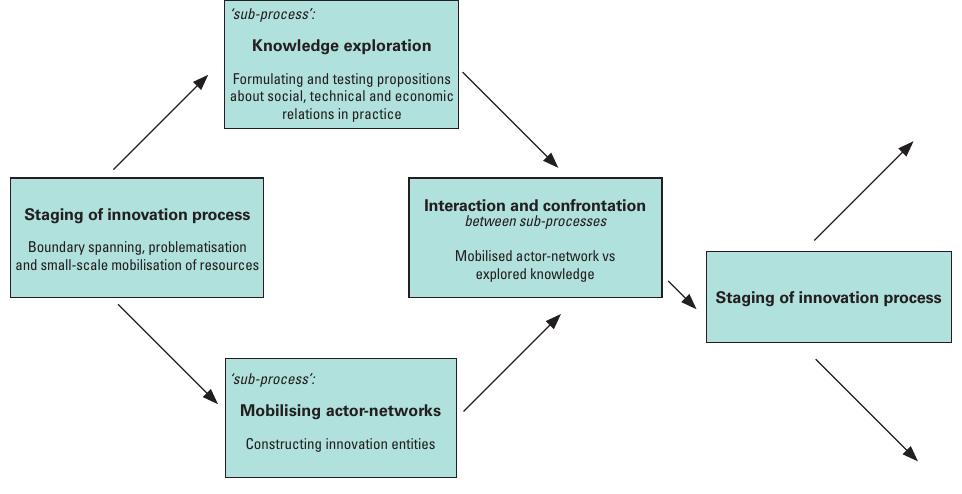
Figure 2: An interactive process model of how to study innovation processes as interaction between processes of mobilisation and exploration in an innovation process (adapted from Hoholm, 2009: